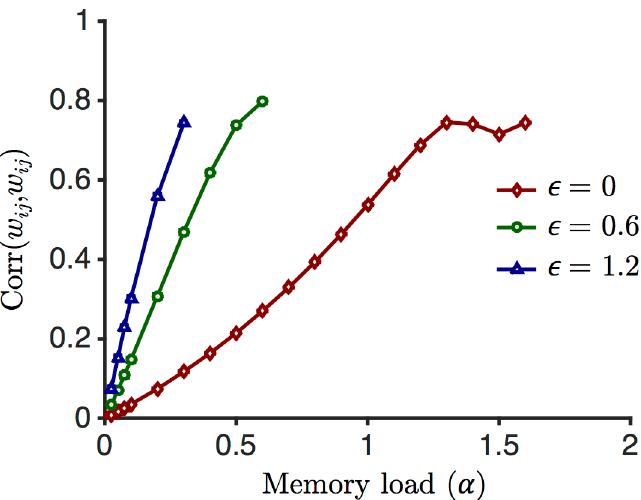
Fig 9. The degree of symmetry of the weight matrix. The Pearson correlation coefficient between w ij and w ji is computed at different values of α for three values of (cid:2) . As α increases the weight matrix tends to be more symmetric, but gets saturated for high α . For the same values of α , as the robustness increases, the correlation also increases, so the weight matrix becomes more symmetric. Error bars (across 10 runs) are smaller than the